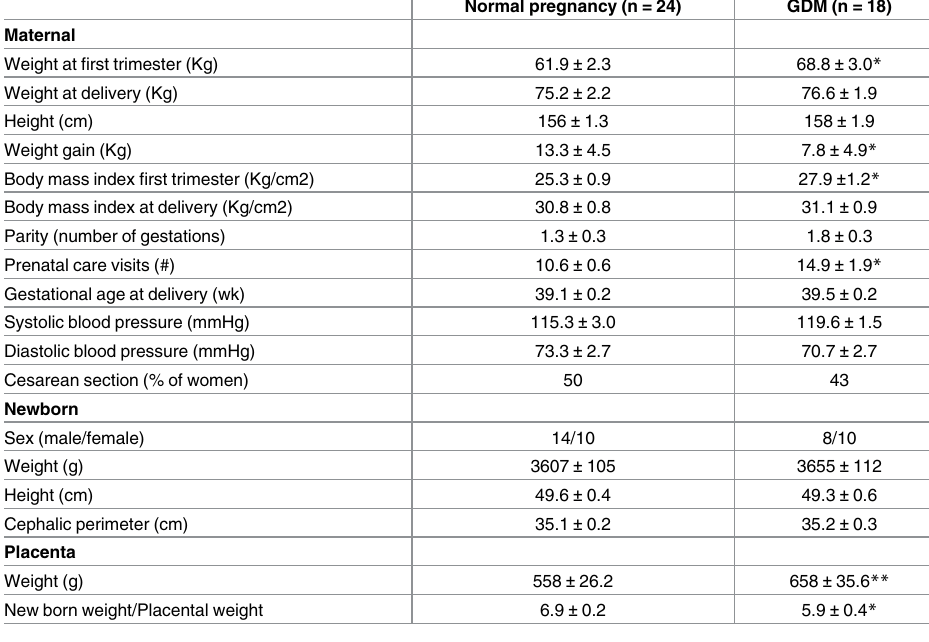
Table 2. Characteristics of women included in the